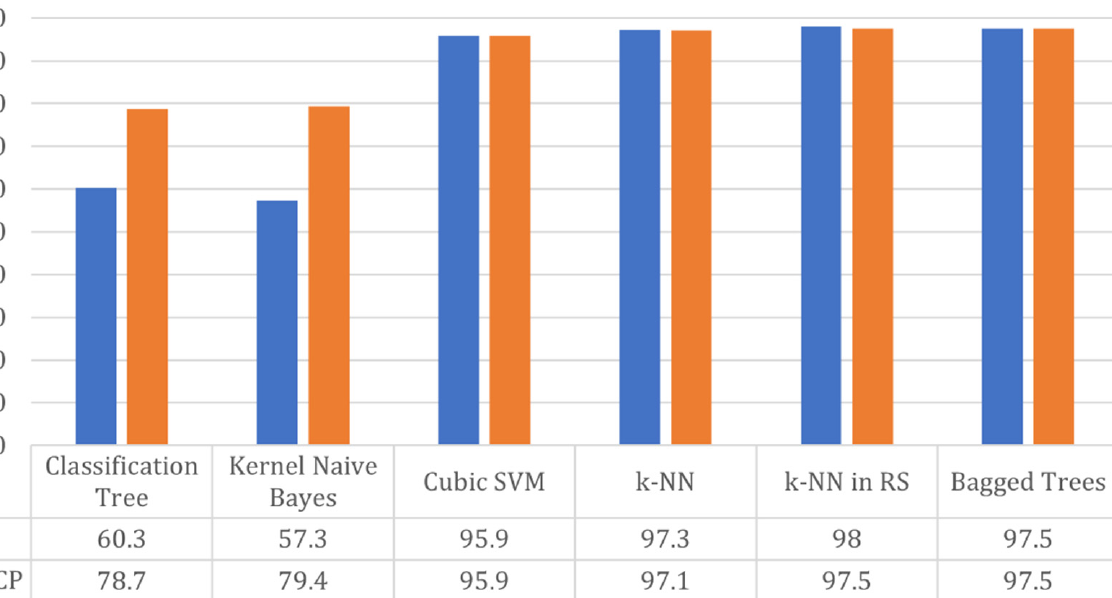
Table 1. The average effectiveness of each of the 6 classifiers tested.